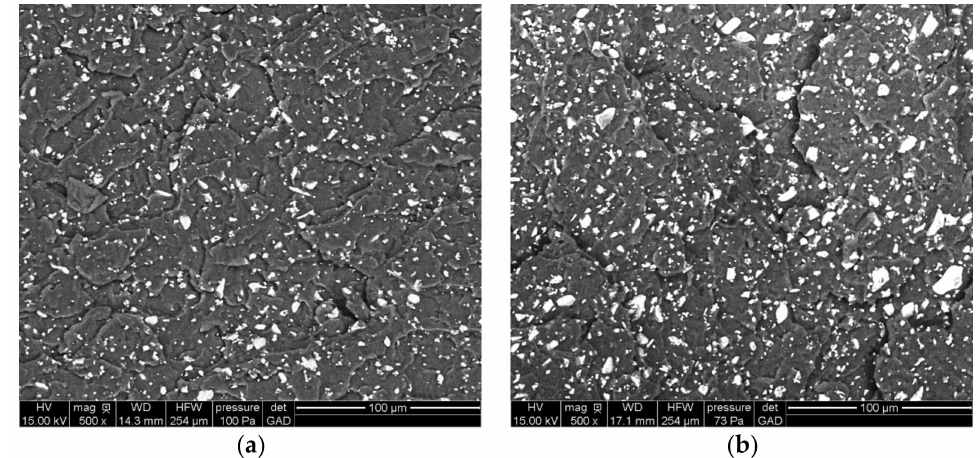
Figure 3. SEM micrographs of cross sections of composite taken in the bulk of ( a ) PDLA30BG 3.5 µ m NT; and ( b ) PDLA30BG 3.5 µ m